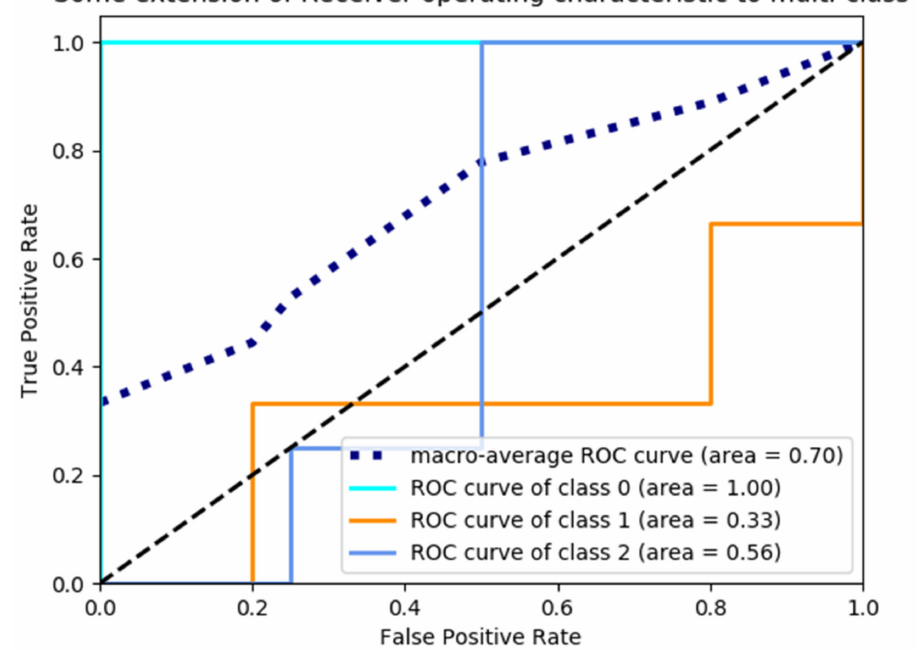
Figure 12. RUS classification model ROC curve and area under the ROC